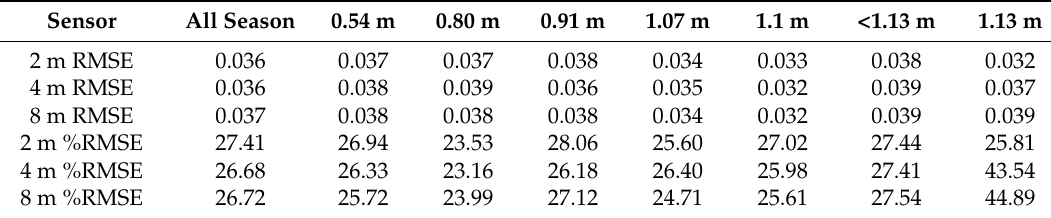
Table 3. RMSE and %RMSE for evapotranspiration separated by period of crop height. Sensor All